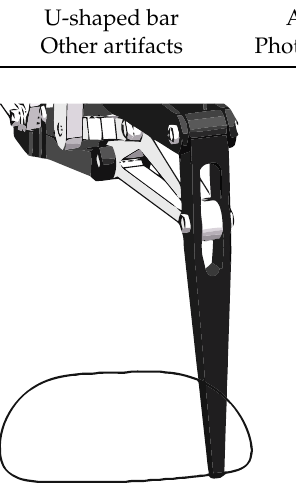
Figure 14. The result of the simulation experiment for a single leg. ( a ) The displacement graph of the foot end on the Y − axis . ( b ) The velocity graph of the foot end on the Y − axis . ( c ) The acceleration graph of the foot end on the Y − axis .